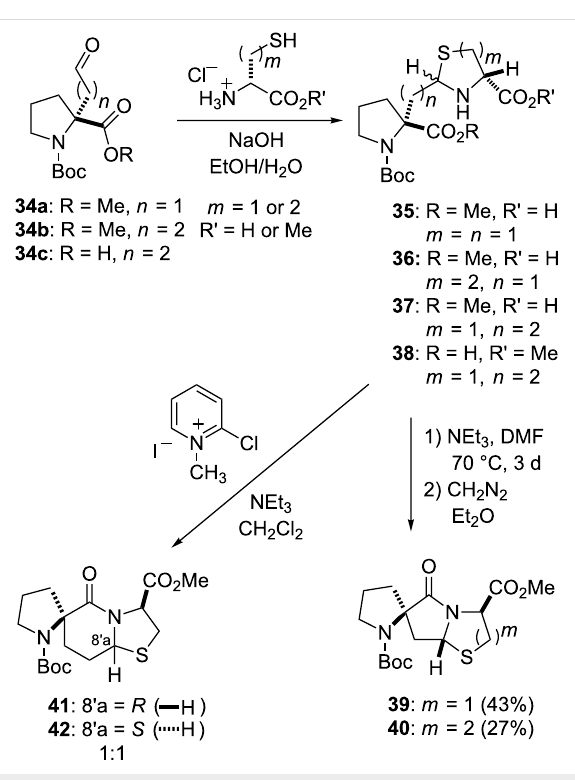
Scheme 2: Synthetic approaches to the spiro-bicyclic scaffolds.